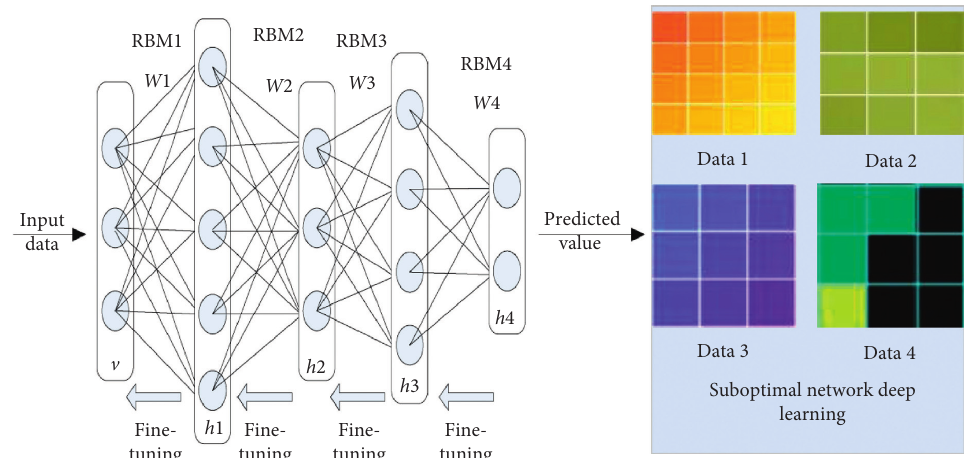
Figure 3: Machine learning-based IoT node classification